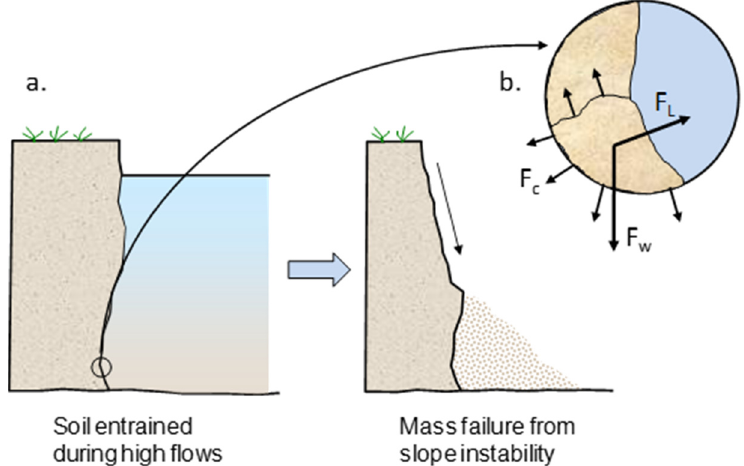
Figure 1. ( a ) Cyclical process of streambank retreat and ( b ) force balance on a soil aggregate, where F w is the submerged body force, F L is the hydraulic lift force, and F c is the cohesive force holding the aggregate to the streambank. For visual clarity, the drag force is not shown.